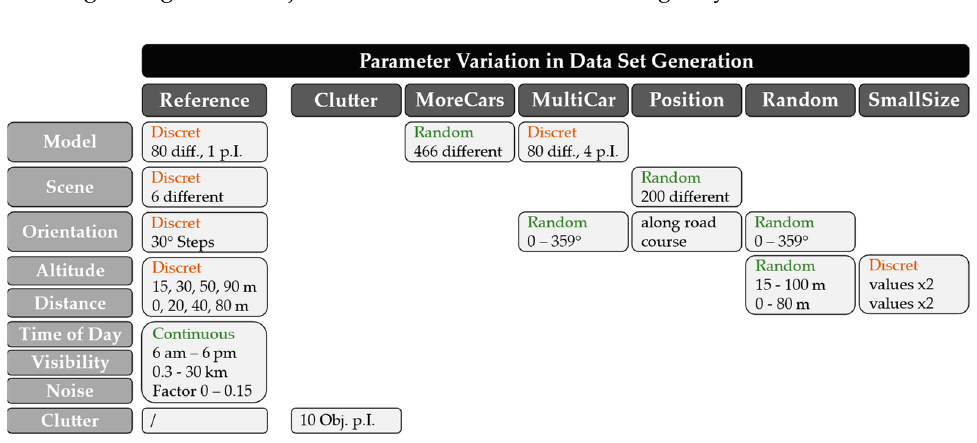
Figure 5. Overview of parameter variations in synthetic training data generation. p.I.: per Image; Obj.: Objects.